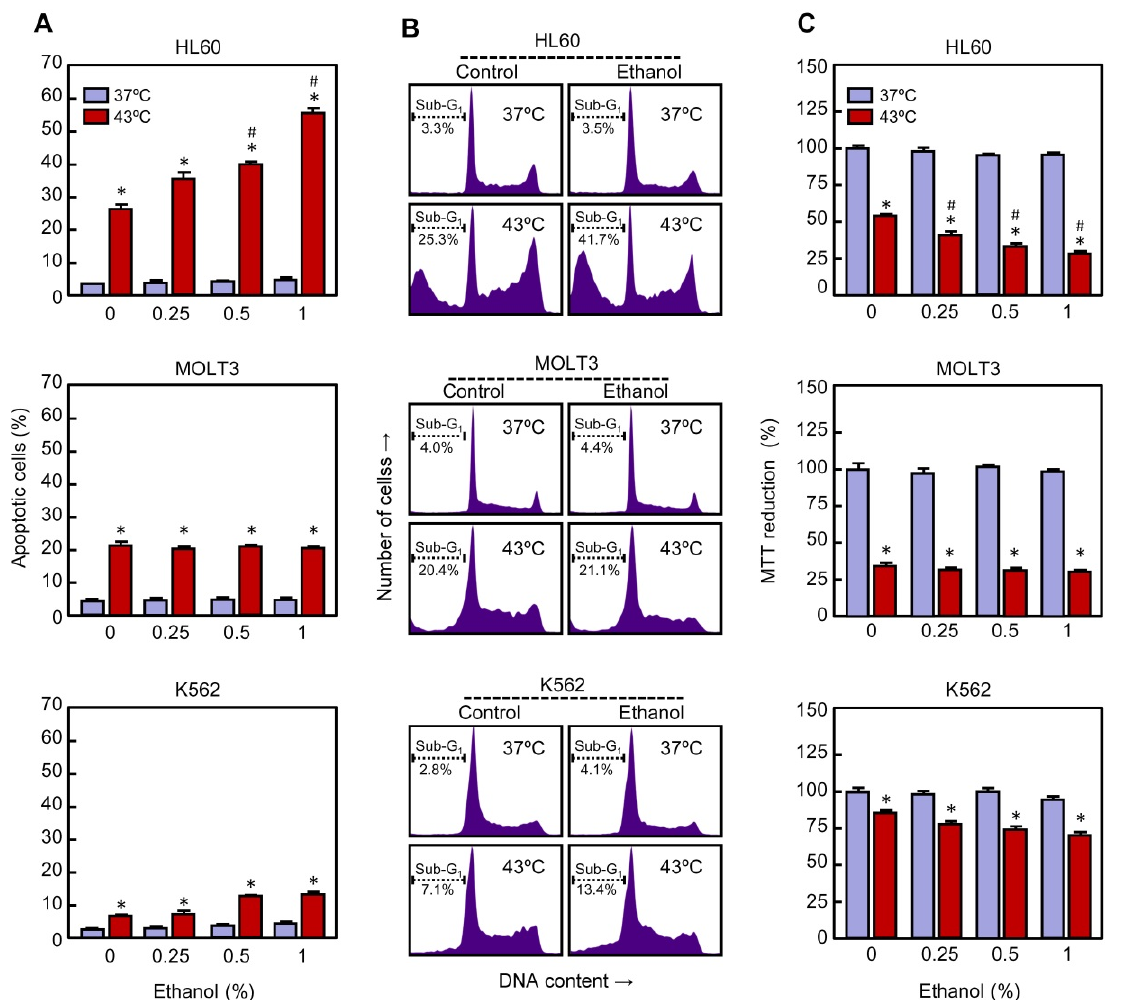
Figure 3. Effect of ethanol on apoptotic cell death in human leukemia cell lines subjected to hyperthermia. The cells were pre-incubated in absence or presence of ethanol for 30 min, exposed to hyperthermia (30 min at 43 °C), and allowed to recover for the indicated period of time. ( A ) The cells were collected after a 3 h period of recovery and cell distribution according to their DNA content was determined by flow cytometry, using the propidium iodide staining procedure; percentage of apoptotic cells (i.e., fraction of cells with sub-G 1 DNA content) is shown. ( B ) The cells were allowed to recover for 3 h and cell distribution according to their DNA content was determined by flow cytometry, as above; the position of apoptotic cells is indicated by a dotted line. Representative histograms are shown. ( C ) The cells were collected following a 24 h period of recovery and cytotoxicity evaluated by the MTT reduction method. * p < 0.05 vs. the respective control at 37 °C; # p < 0.05 vs. hyperthermia (43 °C) treatment alone.